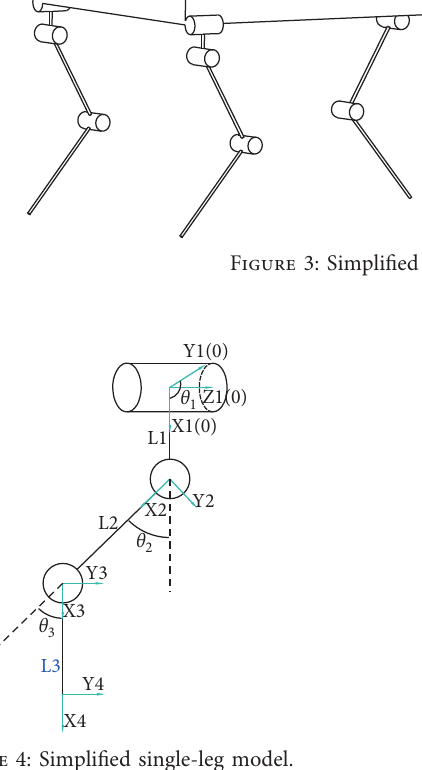
Figure 4: Simplified single-leg model.